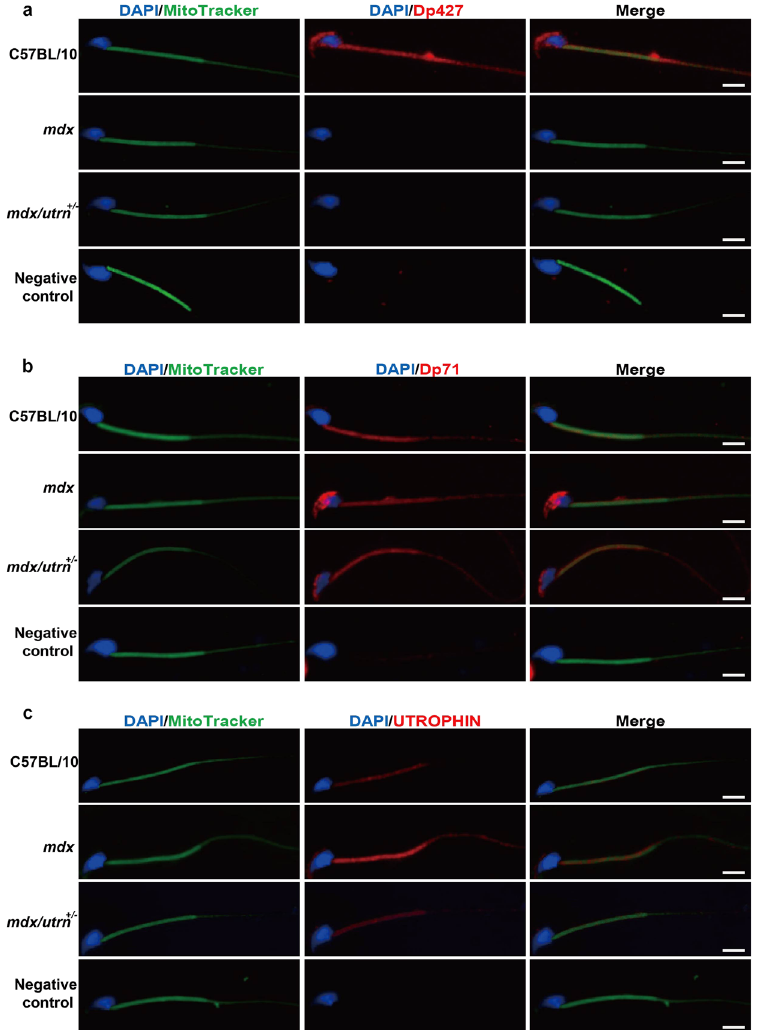
Figure 4. Upregulation of utrophin in response to dystrophin deficiency in spermatozoa. Spermatozoa were isolated from C57BL/10, mdx and mdx/utrn + / − at 10 weeks of age to determine the localization of Dp71, Dp427 and utrophin. The midpiece of spermatozoa were labeled with MitoTracker ® Green and the nuclei were labeled with DAPI. ( a ) Localization of Dp427 in the spermatozoa of C57BL/10 (the 1 st panel), mdx (the 2 nd panel) and mdx/utrn + / − (the 3 rd panel). ( b ) Localization of Dp71 in the spermatozoa of C57BL/10 (the 1 st panel), mdx (the 2 nd panel) and mdx/utrn + / − (the 3 rd panel). ( c ) Distribution of utrophin in the spermatozoa of C57BL/10 (the 1 st panel), mdx (the 2 nd panel) and mdx/utrn + / − (the 3 rd panel). The 4 th panels of ( a – c ) were Negative control. Scale bar: 5 μ The number of spermatogenic cells diminishes in the mdx and mdx/utrn + / − testes. Spermatogenesis, a process involving differentiation of spermatogonia to spermatocytes and eventually the sper- matids, initiates within the seminiferous tubules of the testis and requires the support of Sertoli and Leydig cells (Fig. 6a). To establish whether the deficiency of dystrophin/utrophin has an influence on germ cells, we focused on the changes of germ cell number. The spermatozoa concentration of the mdx and utrnko cauda epididymidis were less than that of C57BL/10 by 28% and 21% respectively though not statistically significant; moreo- ver, the spermatozoa concentration further reduced by 58% in the mdx/utrn + / − cauda epididymis compared to C57BL/10 (Fig. 6b). In addition, there was a dramatic decrease of viable spermatozoal concentration deter- mined with computer-assisted sperm assay in the mdx cauda epididymis (1.27 ± 0.12 million/ml) compared to C57BL/10 (8.17 ± 0.42 million/ml); the viable spermatozoal concentration further decreased in the mdx/utrn + / − epididymis (Supplementary Fig. 2b), reflecting that both dystrophin and utrophin play a role during spermat- ogenesis. We then investigated the average number of germ cells per seminiferous tubules at spermatogenic stages VII-VIII to determine the effects of dystrophin/utrophin insufficiency on spermatogenesis (Fig. 6c). The number of Sertoli cells per seminiferous tubule did not differ among C57BL/10, mdx and mdx/utrn + / − testes (Fig. 6c,d). However, the number of spermatogonia per seminiferous tubule decreased from 33.08 ± 2.24 in C57BL/10 to 20.78 ± 2.52 in mdx and further to 13.80 ± 1.696 in mdx/utrn + / − (Fig. 6c,e). In addition, the number